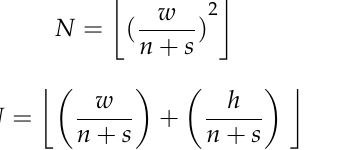
Table 2. SVM kernel parameter optimization .